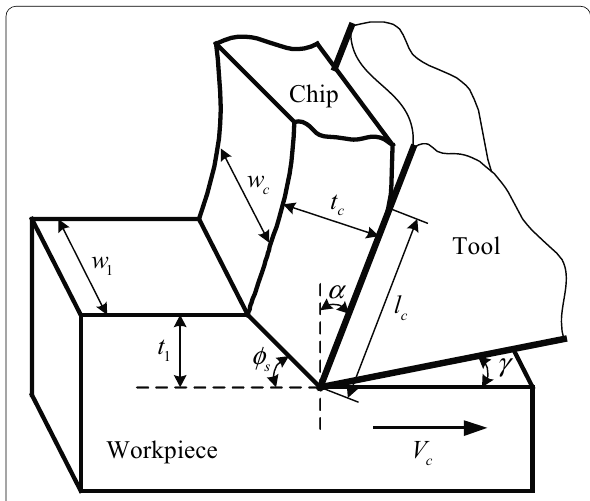
Figure 2 Orthogonal cutting configuration and parameters for a continuous chip [51, 65, 66